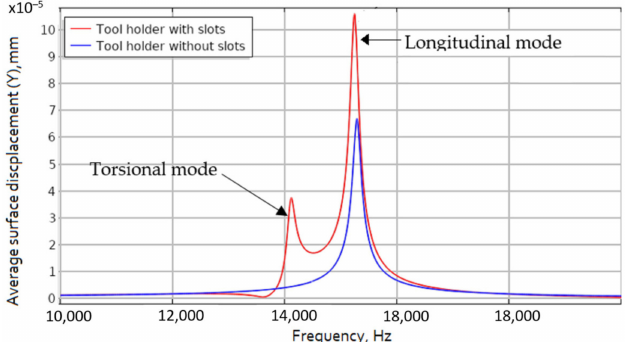
Figure 4. Average displacement amplitude in longitudinal direction for horn with and without